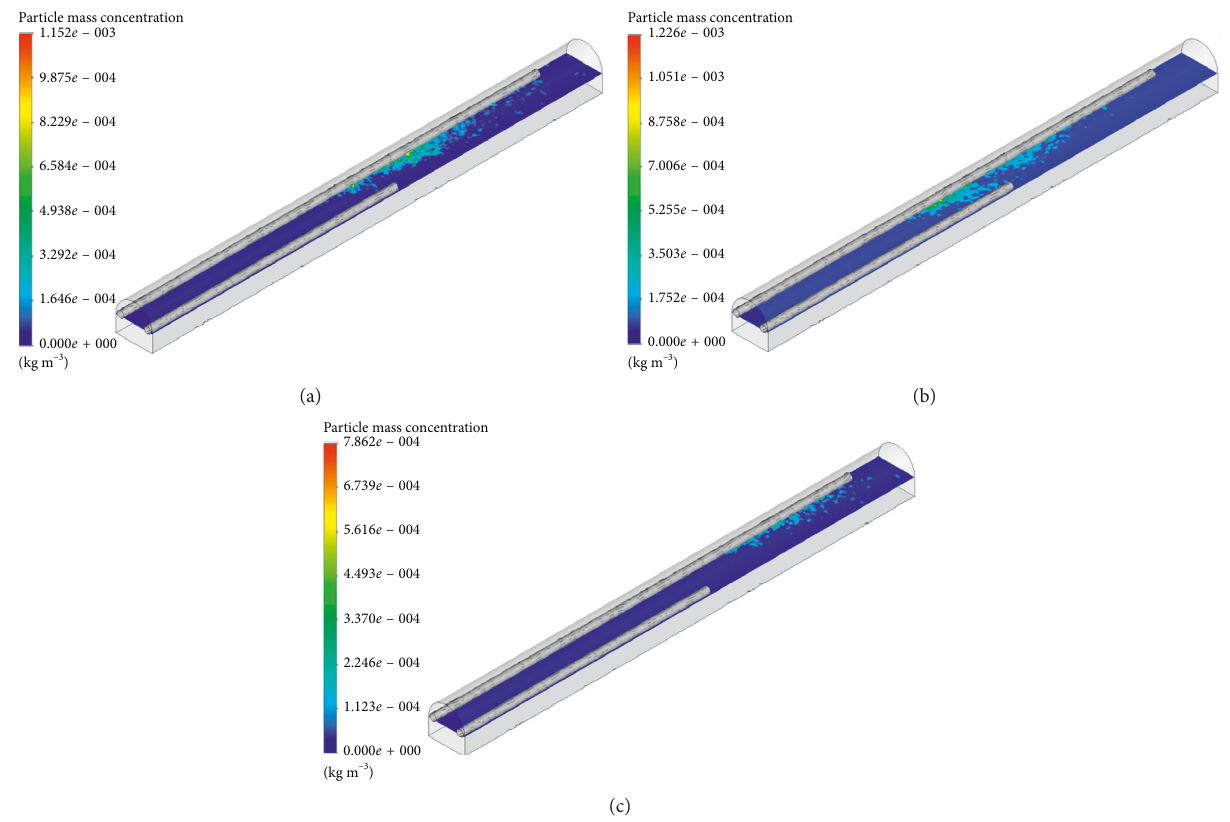
Figure 9: Influence of K on the mass concentration of dust. (a) 0.8 m, (b) 1.0 m, and (c) 1.2m.